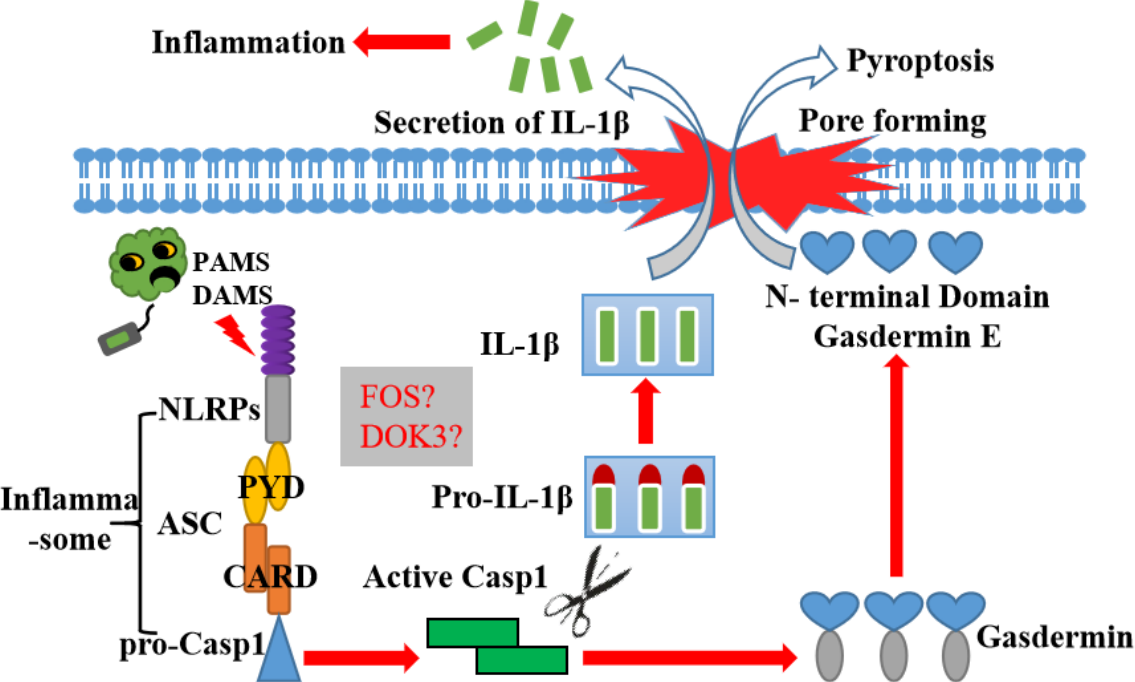
Figure 8. Putative inflammasome signal pathway in most fish.